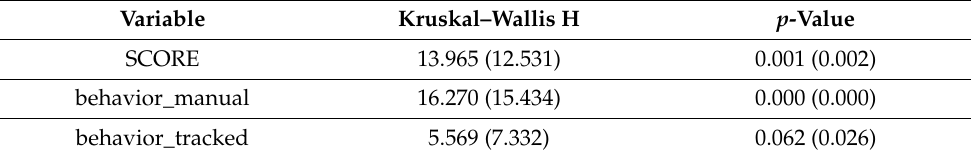
Table 4. Kruskal–Wallis H tests.